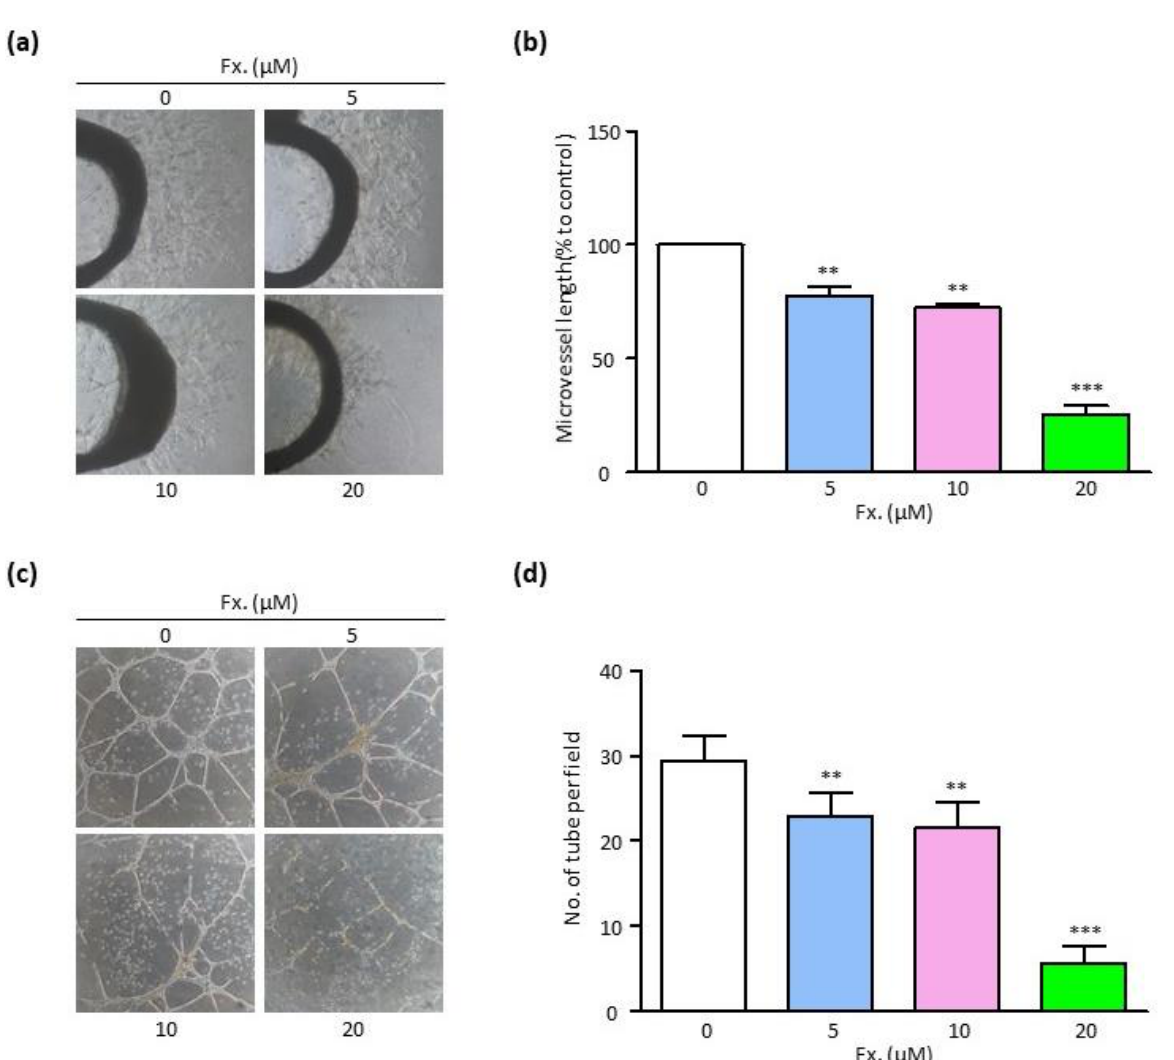
Figure 3. Fucoxanthin inhibits endothelial cell sprouting and tube formation. ( a , b ) Images showing sprouting of microvessels from rat aorta ( a ) and comparison of maximal length of microvessel ( b ) in treatment with fucoxanthin (0, 5, 10, and 20 µ M) for 7 days. Magnification, 40 × . ( c , d ) Images showing EC tube formation ( c ) and comparison of the number of tubules ( d ) in treatments with fucoxanthin (0, 5, 10, and 20 µ M) for 18 h. Magnification, 100 × . Fx., Fucoxanthin. Values are presented as the mean ± SD of three independent experiments. ** p < 0.01, *** p < 0.001.